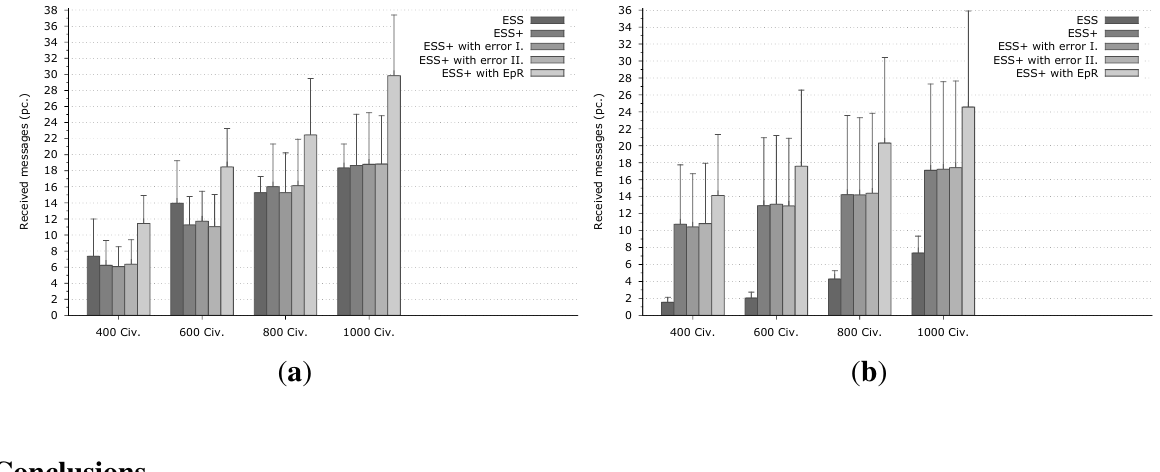
Figure 6. Communication results of the emergency systems. The starting position of the fire was node 16 − 0 at ( a ) and 100 − 2 at ( b ). The first four columns in each group is the same as in previous figures, however, the fifth is a new one, indicating the enhanced ESS with Epidemic Routing. ( a ) The fire was generated at node 16 − 0 ; ( b ) The fire was generated at node 100 − 2